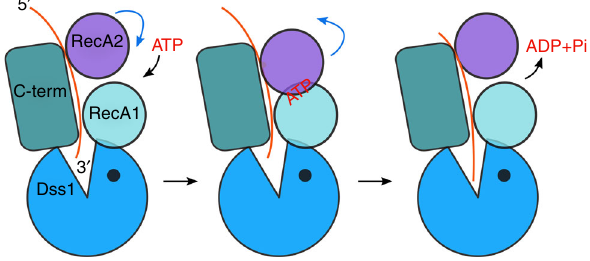
Fig. 6 Proposed mechanism of RNA degradation by Cg- mtEXO. The cycle of ATP binding, hydrolysis and ADP release (black arrows) induces conformational changes of Suv3 helicase (blue arrows). The RecA2 domain (purple) would move toward the RecA1 domain (cyan) and away from it (blue arrows), while Suv3-Dss1 contacts would be maintained. The movements of RecA domains lead to the translocation of the 3 ′ end of the RNA (orange) into the RNA-binding channel and toward the active site of Dss1